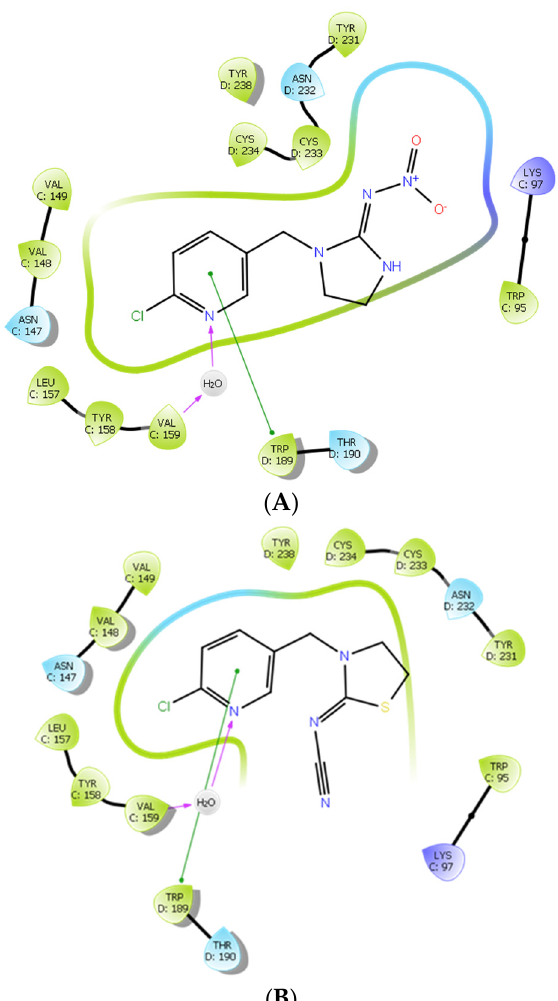
Figure 6. 2D interaction diagrams of the ligand-receptor interactions established within the CD interface of the cockroach Pame α 7 receptor for ( A ) IMI and ( B ) THI.